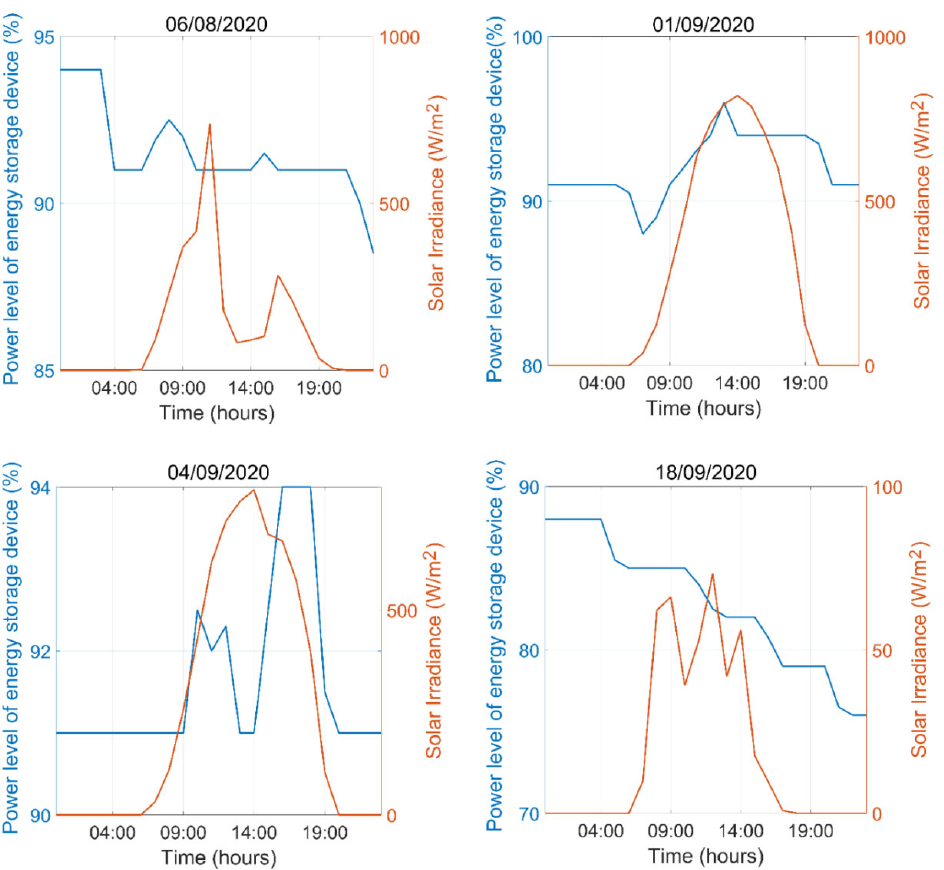
Figure 9. A comparison between the power level of the energy storage device and solar irradiance.